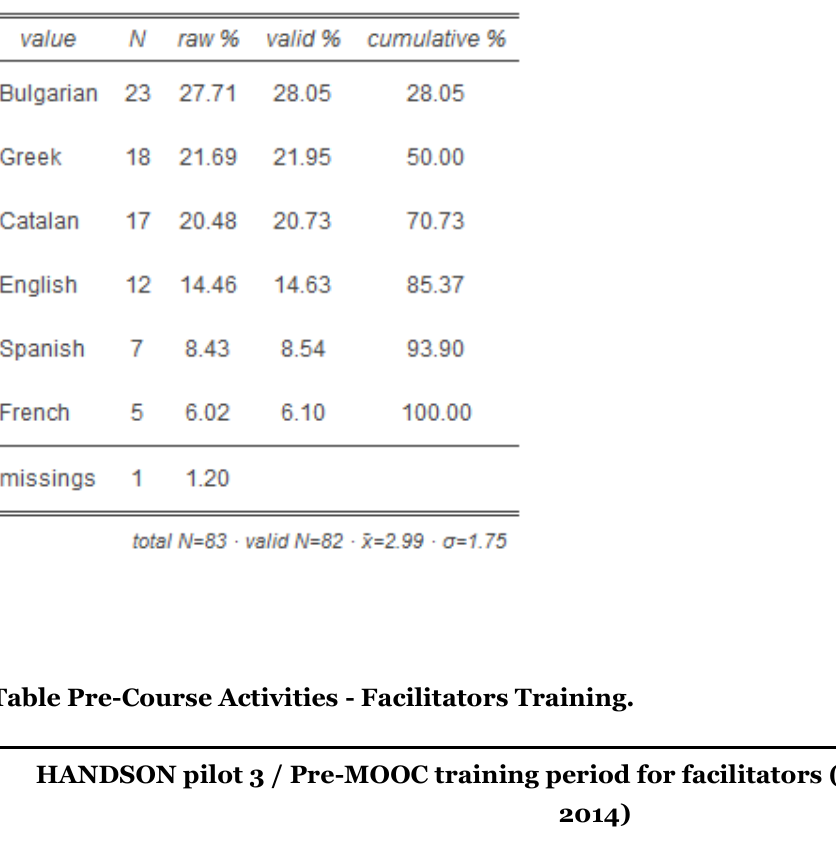
Table PostPilot3 – Which Language Group Did You Join.